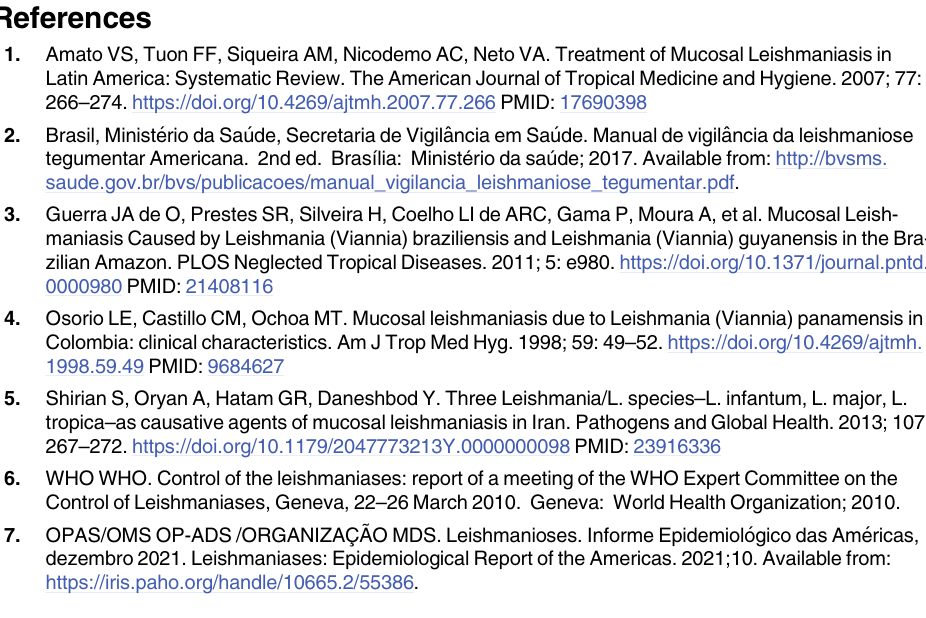
S4 Table. High Level Group Terms for the Investigation System Organ Classes Term by Therapy. AE: Adverse Event. HLGT : High Level Group Terms. L-AMB : Liposomal ampho- tericin B. MF : Miltefosine. Sb v : Antimonial pentavalent. SOC : System Organ Classes. SSG : Sodium